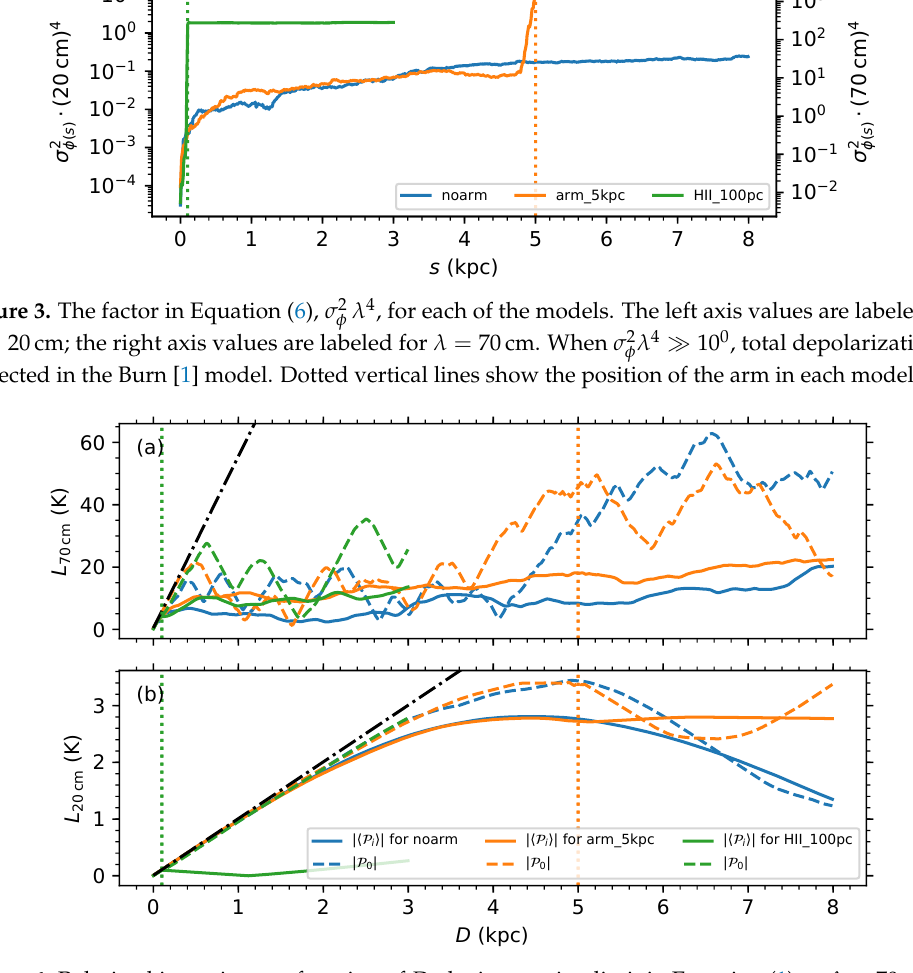
Figure 4. Polarized intensity as a function of D , the integration limit in Equation (1), at λ = 70cm ( a ) and 20cm ( b ). The solid lines show the polarized intensity over the beam, |(cid:104)P i (cid:105)| . The dashed lines show the polarized intensity in one randomly-chosen individual sightline within the beam, |P i | . Vertical dotted lines show the position of the spiral arm in the model with the corresponding color. Dotted-dashed lines show the polarized intensity in the absence of depolarization effects (Equation (9)). Note that integrated polarized intensities (Moment 0) are shown in Figure 7 below. Dotted vertical lines show the position of the arm in each